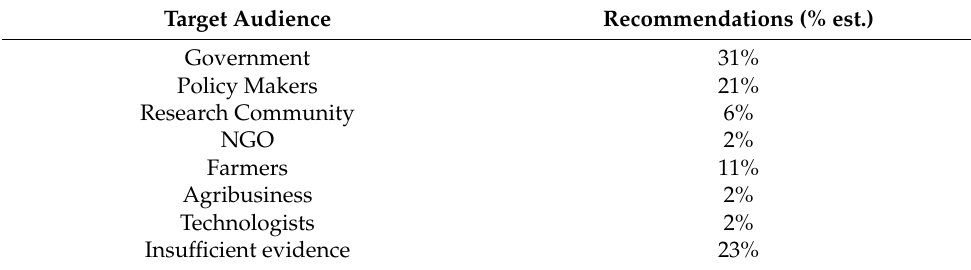
Table 4. Target audiences of